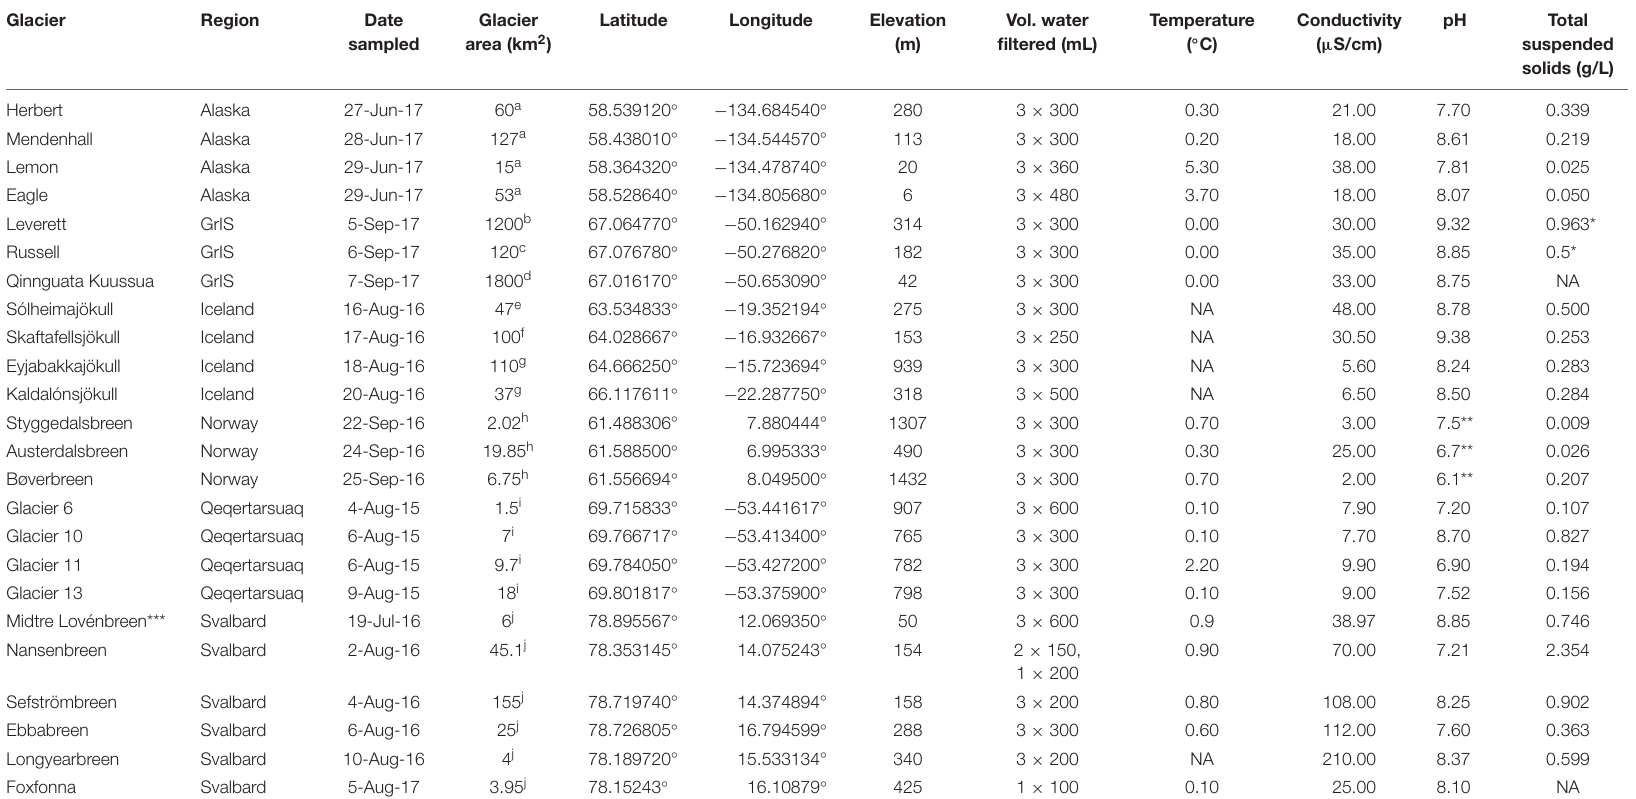
TABLE 1 | Physical characteristics of meltwater